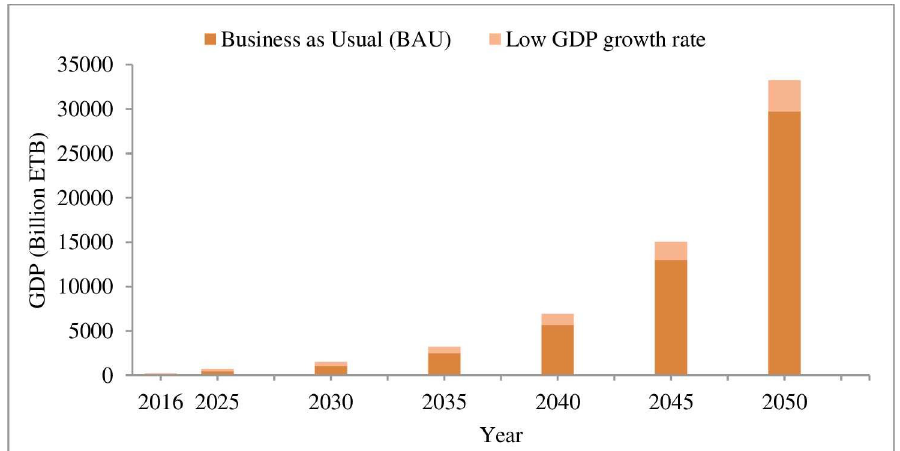
Fig 10. Projected GDP of Addis Ababa city. The GDP under business as usual is greater by 40% and 12% in 2030 and 2050 respectively as compared to the low GDP growth rate, this indicates a high gap between the GDP predicted between two